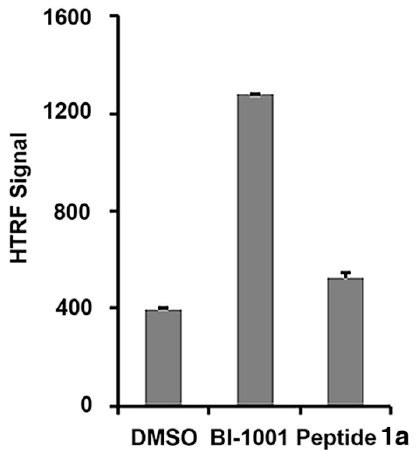
Figure 3. Effects of peptide 1a on integrase multimerization. HTRF-based integrase multimerization signal recorded with a control ALLINI compound ( BI-1001 ) [27] or 100 µM of peptide 1a . Each data point represents the mean of three independent experiments.